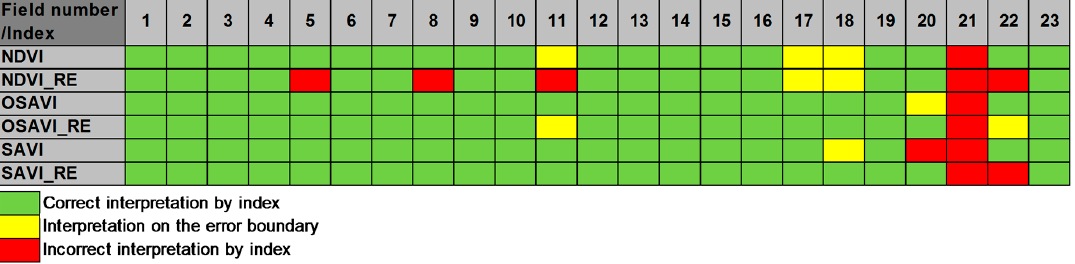
Figure 5. Errors of the classification for training fields intended for compensation process.